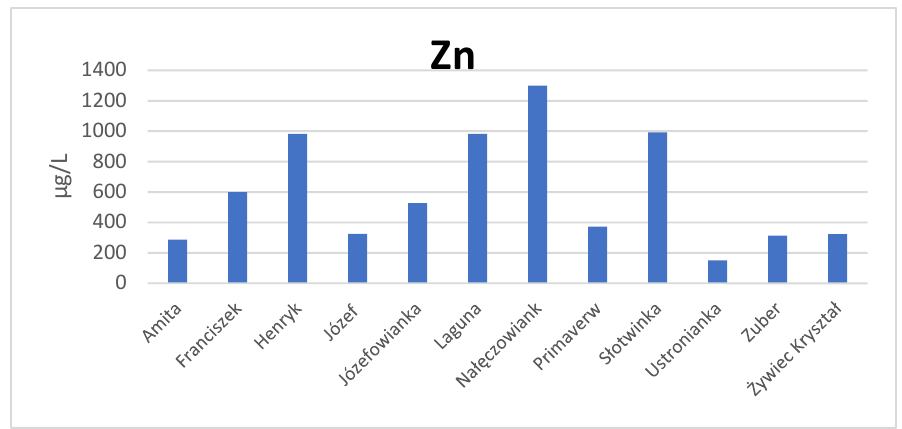
Figure 13. The concentration of zinc in mineral waters ( μg/L ).